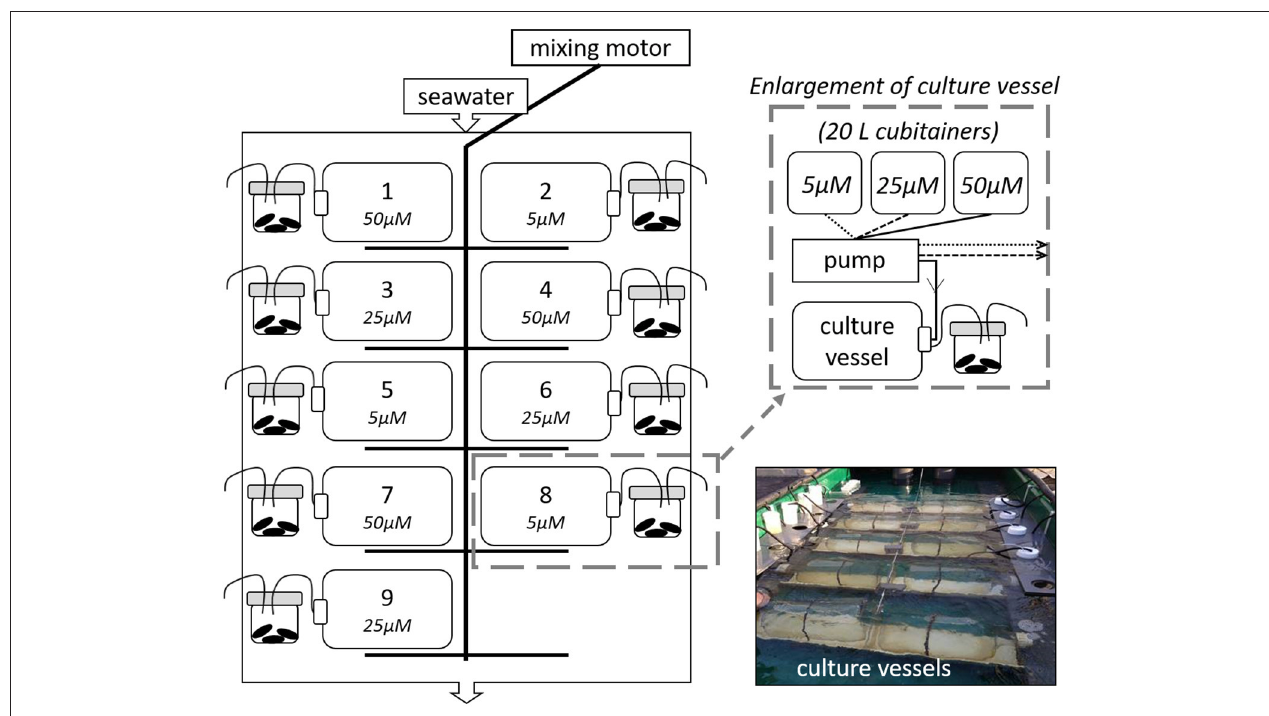
FIGURE 1 | A schematic of the Ecostat experimental setup. The graphic on the left illustrates the flow-through seawater table where the culture vessels were kept. Each culture vessel was randomly assigned to a mixing cradle, which was gently rocked via an electric motor throughout the experiment. Twenty liter cubitainers of treatment water fed each vessel and vessel effluent water subsequently fed a mussel chamber containing three blue mussels ( Mytilis edulis ). The schematic in the top right shows the links between cubitainers of stock solution, pump, culture vessel, and mussels. The picture in the lower right shows the Ecostat at the onset of an experiment. The continuous culture system (Ecostat) is modified from Grear et al. (2017) and based on Pickell et al.